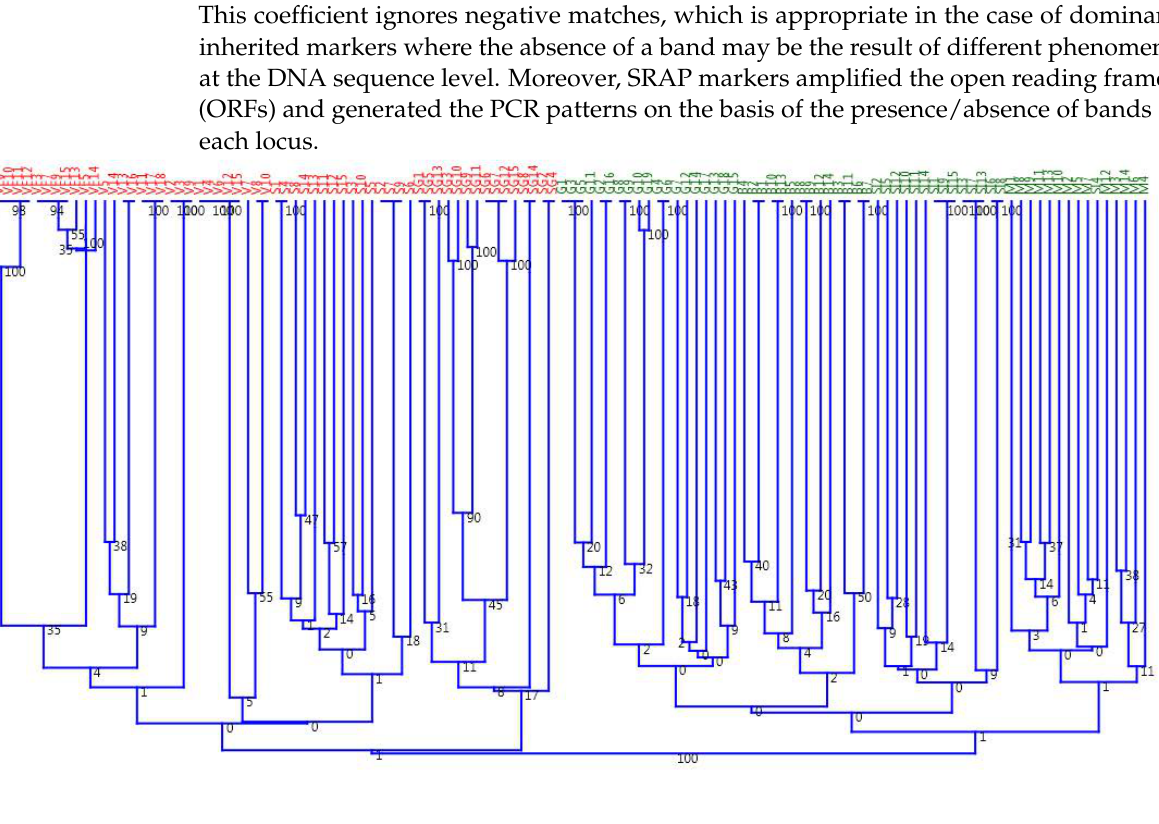
Figure 2. UPGMA dendrogram generated by SRAP markers, showing the relationships among A. exscapus subsp. transsil- vanicus individuals and based on Jaccard’s coefficient. The two main clusters included (A, red) individuals from Valea Florilor (VF), Vii¸soara (V), S ă bed (S), and S ă rm ă ¸sel Gar ă (SG) populations and (B, green) individuals from G ă d ă lin (G), Beleni (B), Siliva¸su de c â mpie (SI), and Mil ă ¸sel (M) populations. Numbers on the branches show bootstrap values, computed from 9999